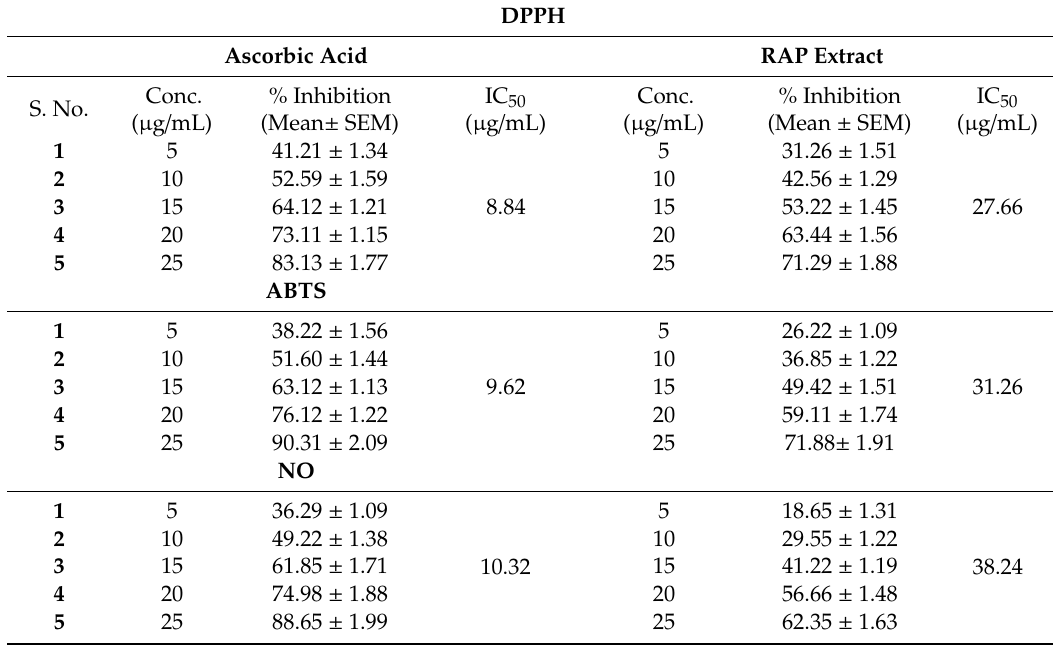
Table 4. Antioxidant activity of Rhododendron arboreum polysaccharides (RAP) on 2,2-diphenyl-1-picryl hydrazyl radical (DPPH), 2,2 (cid:48) -azino-bis (3-ethylbenzothiazoline-6-sulfonic acid) (ABTS), and Nitric oxide